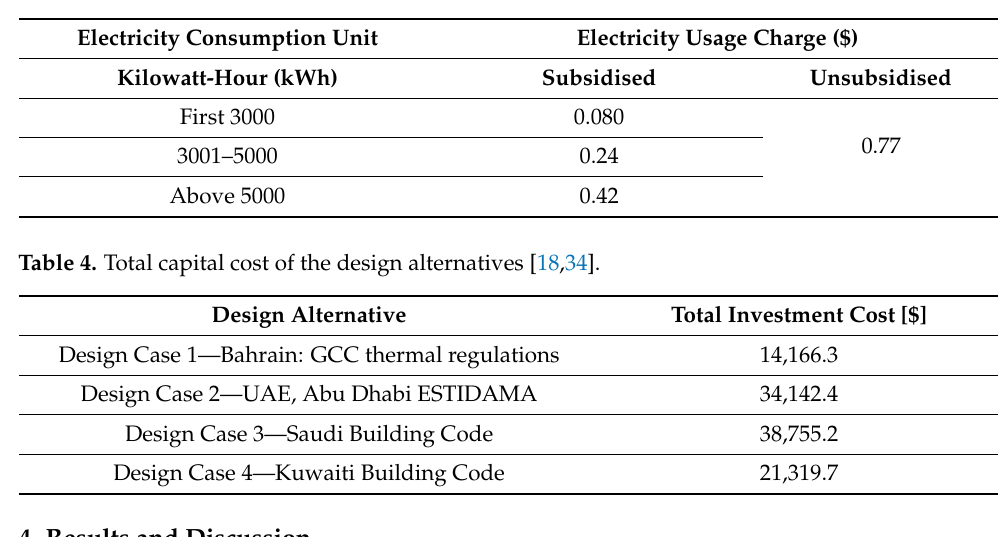
Table 3. Subsidised and unsubsidised electricity consumption tariff.